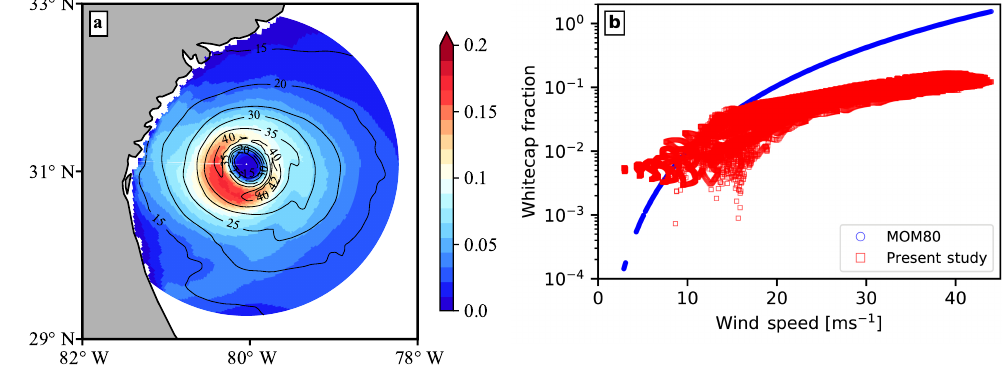
Figure 12. Computed whitecap fraction from Expt. 4 at 00:00UTC on 3 July 2014. (a) Distribution of the whitecap fraction with contours of mean wind speed U 10 . (b) Comparison of the whitecap fraction (on log scale) with mean wind speed U 10 .